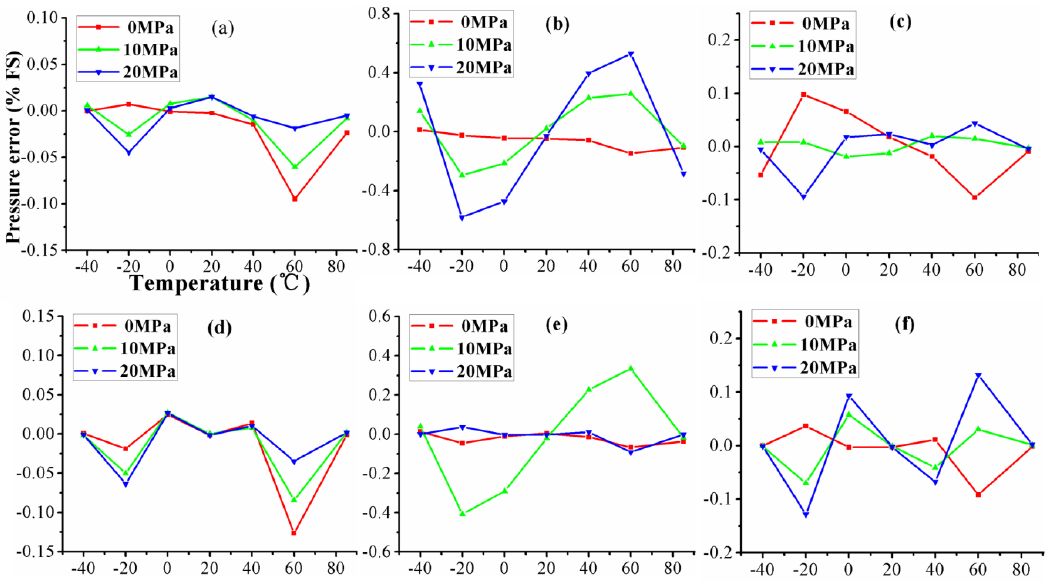
Table 6. Performances of sensor calibrated by algorithms using 5 × 11 calibration.